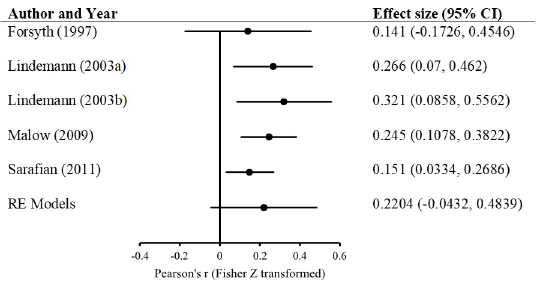
Fig 4. Forest plot of studies included in